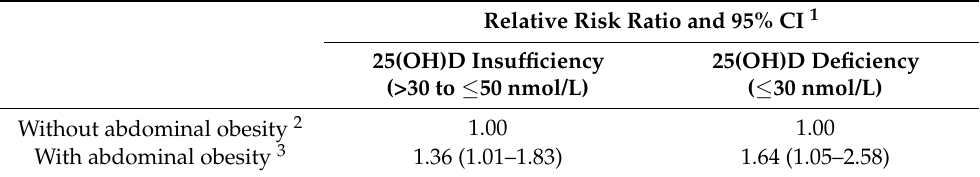
Table 3. Final adjusted model for incidence of serum 25(OH)D insufficiency and deficiency during 4-year follow-up according to abdominal obesity status, ELSA Study (2012–2016).